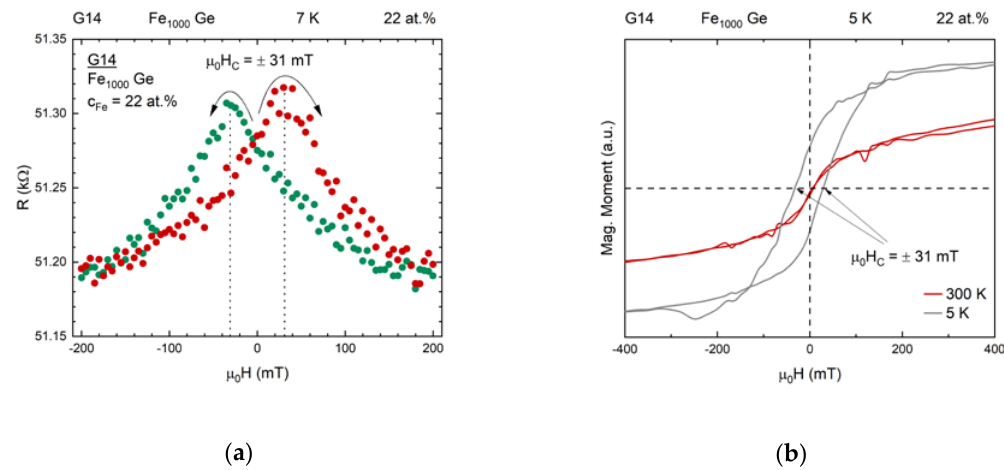
Figure 11. ( a ) Absolute resistance vs. magnetic field of sample G14 recorded at 7 K. The arrows and the color coding indicate the sweeping direction of the field. The points of maximum resistance at ± 31 mT are passed after zero-crossing. ( b ) Magnetization vs. magnetic field shows hysteretic dependence at 5 K, again with a coercive field µ 0 H C = ± 31 mT. The correspondence between coercive field and field of maximum resistance proves that the alignment of the clusters’ magnetic moments causes the resistivity of the sample to decrease.